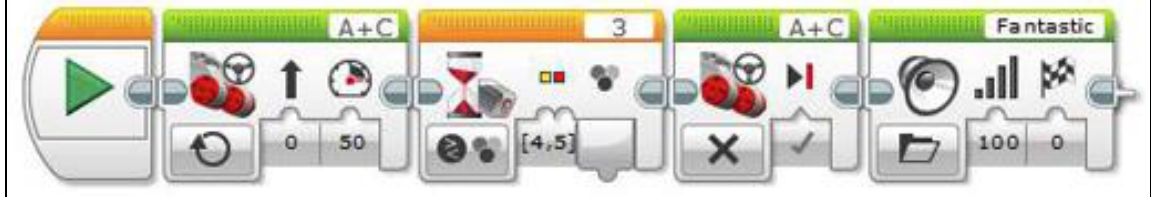
Figure 4. An EV3 software program that makes the robot drive forward until the colour red or yellow is seen. Then the robot stops and shouts